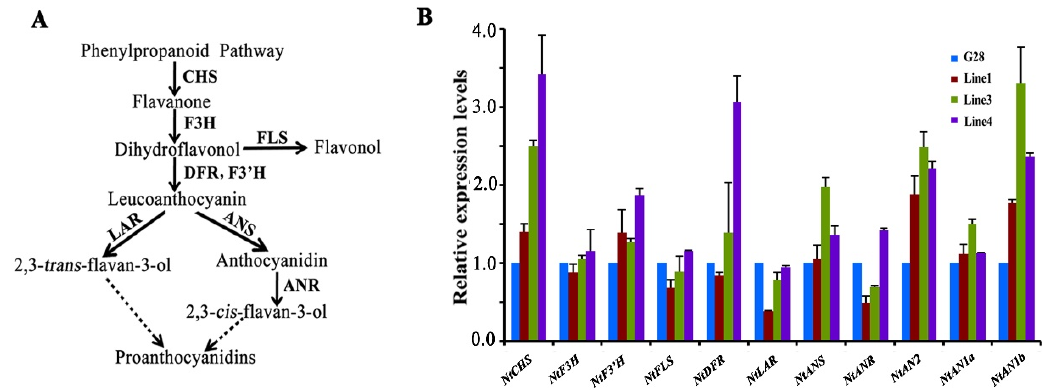
Figure 4. Expression of genes involved in flavonoid biosynthesis in the flowers of CsWD40-overexpressing tobacco plants. ( A ) A schematic diagram of flavonoid biosynthetic pathway. ( B ) Expression profiles of genes in flavonoid pathway in flowers of transgenic CsWD40 tobacco lines. CHS, chalcone synthase; F3H, flavanone 3-hydroxylase; F3 (cid:48) H, flavonoid 3-hydroxylase; DFR, dihydroflavonol reductase; ANS, anthocyanidin synthase; ANR, anthocyanidin reductase; FLS, flavonol synthase; AN2, N. tabacum Anthocyanin 2; AN1a, N. tabacum Anthocyanin 1a; AN1b, N. tabacum Anthocyanin